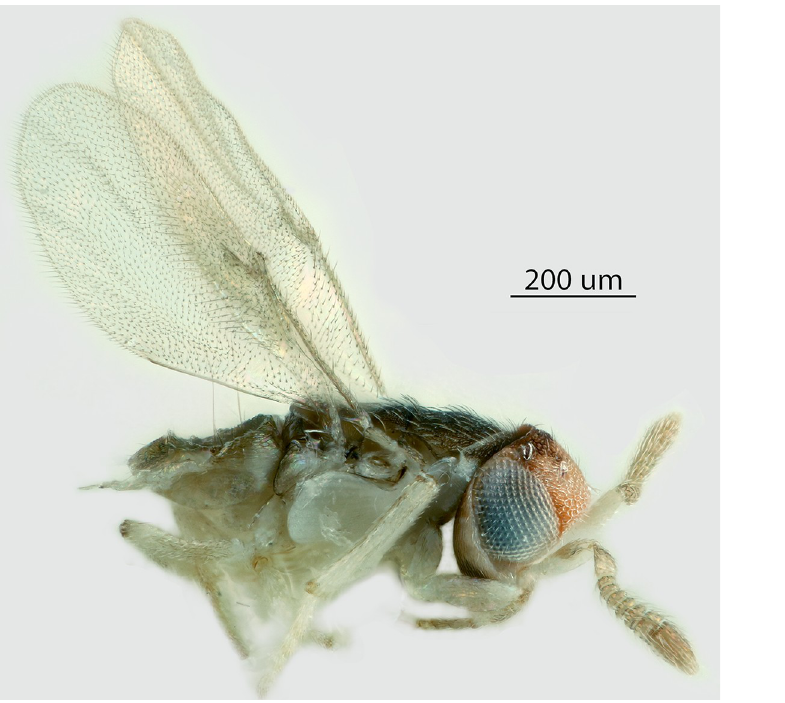
Fig 10. M . macadamiae male, lateral habitus.